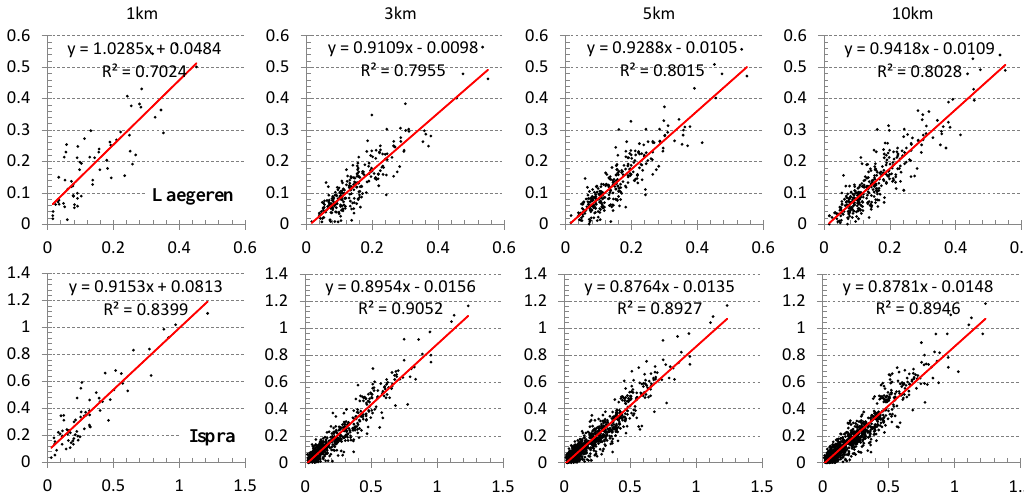
Fig. 3. MAIAC-AERONET AOT 0 . 47 scatterplots for Laegeren, Switzerland, and Ispra, Italy, based on MODIS Terra 2000–2008 data. The four plots in a row represent MAIAC data at original 1km resolution, and for a 3, 5 and 10km window.